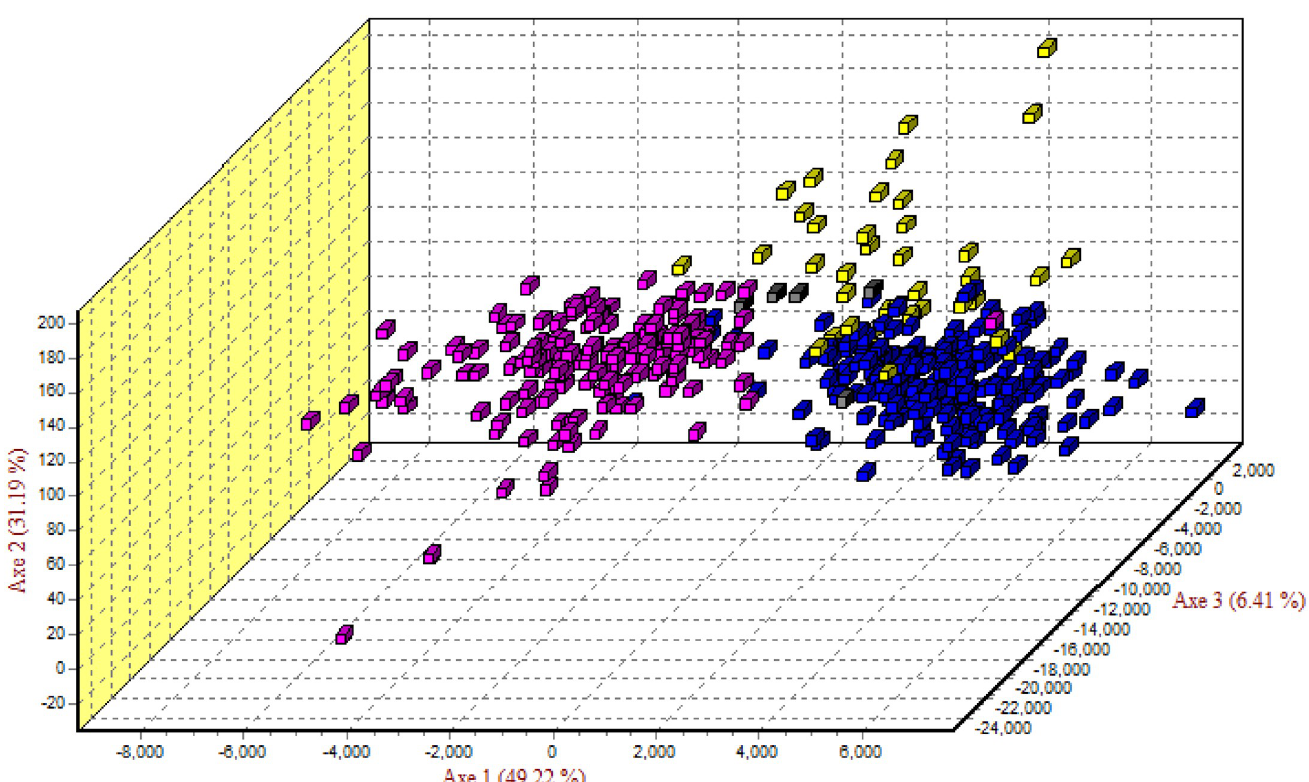
Fig 4. Factorial correspondence analysis (FCA) based on 14 microsatellite loci of 398 Zambian lions. Pink = Western Zambia (KF & SI), Blue = Luangwa Valley (LV), Yellow = Lower Zambezi NP and eastern corridor (ZA & CO), Grey = Outside PAs. Axe 1, 2, and 3 represent 86.82% of the genetic variation observed.